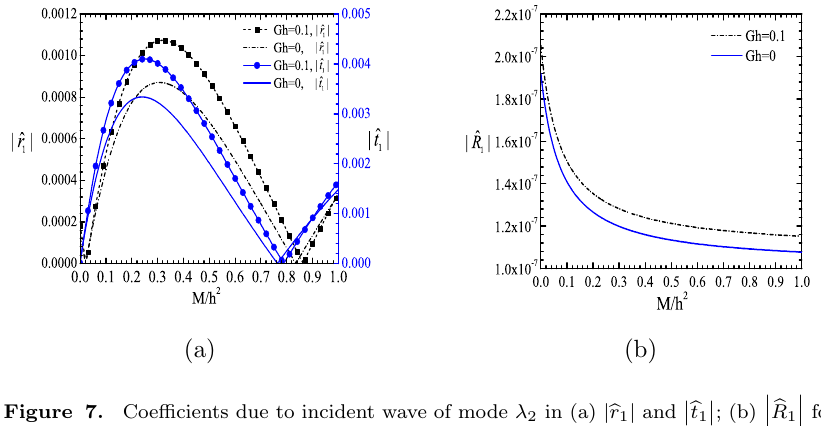
Figure 7. Coefficients due to incident wave of mode λ 2 in (a) | (cid:98) r 1 | and (cid:12) (cid:12)(cid:98) t 1 (cid:12) (cid:12) ; (b) ρ = 0 . 5, H/h = 2, Kh = 0 . 5, γh = 1, a/h = 0 . 1, m = 5 ,n =